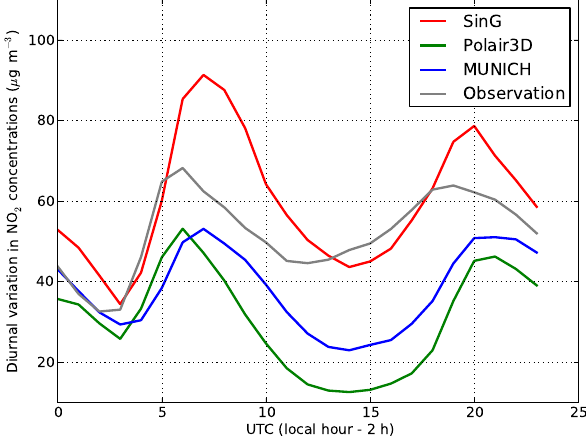
Figure 8. Diurnal variation in NO 2 concentrations modeled with MUNICH (blue line), Polair3D (green line), and the SinG model (red line). They are compared to the measured concentrations (black line) at the stations nearby traffic on each sidewalk of Boulevard